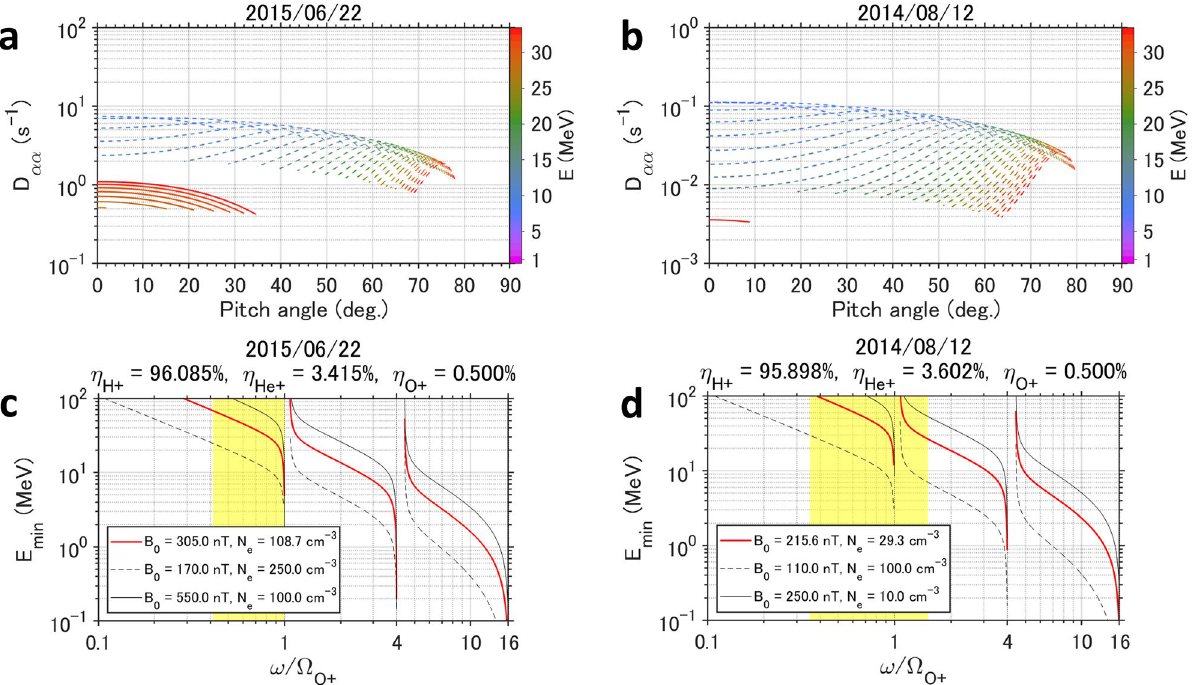
Figure 4. Equatorial pitch angle diffusion and the minimum resonant energy of electrons for observed conditions. ( a , b ) Equatorial pitch angle diffusion as a function of equatorial pitch angle. Each curve is plotted every 1 MeV. Solid curves are the calculation results using observed conditions and dotted curves are for a low geomagnetic field strength and a high electron density. ( c , d ) Minimum resonant energy as a function of the EMIC wave frequency normalized by the cyclotron frequency of O + ions (cid:31) O + . The yellow rectangle indicates the observed frequency range of the EMIC/Pc1 waves, where B 0 is the geomagnetic field intensity at the magnetic equator and N e is the electron density. Red bold curves are the calculation results using observed conditions. Black solid and dotted curves are for the typical values of B 0 and N e